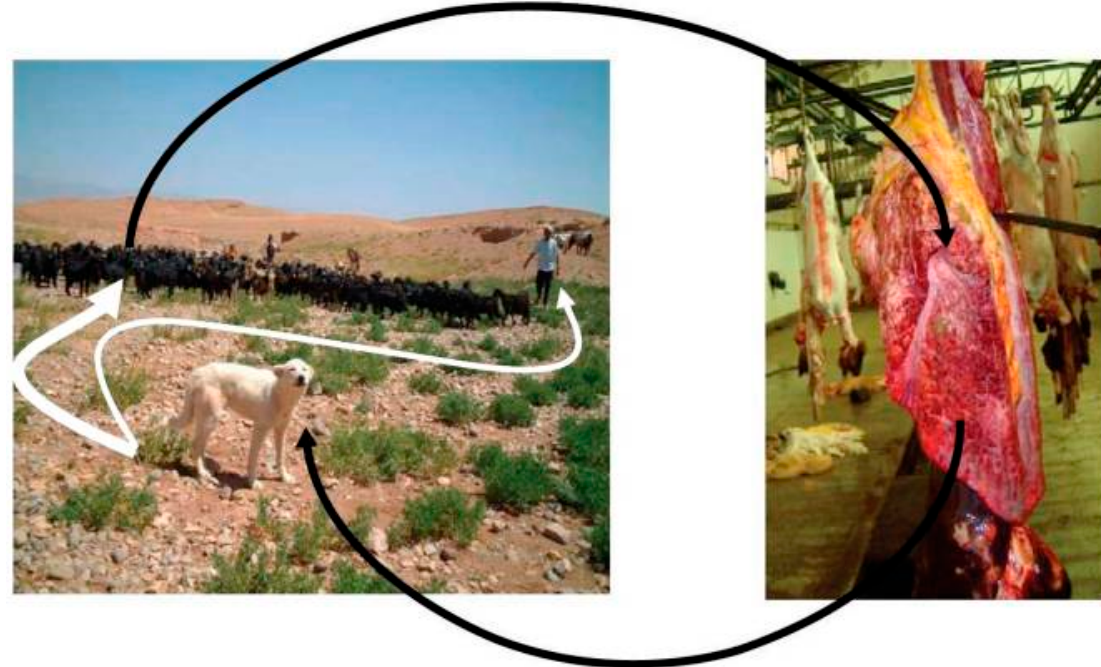
Figure 1. Life cycle of E. granulosus [6]. Copyright notice: The link of original article: (https://journals.plos.org/plosntds/article?id=10.1371/journal.pntd.0001146), the link of the Creative Commons Attribution License (http://creativecommons.org/licenses/by/2.0), if any changes were made in the original picture: □ Yes ☑ No.